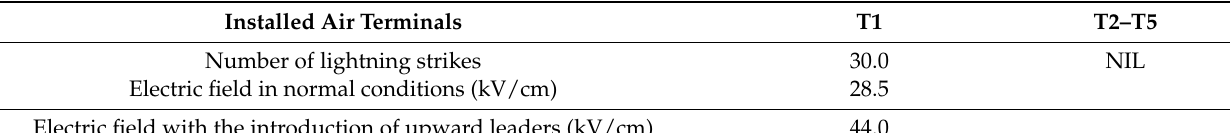
Table 9. Number of strikes and electric field on a pyramid-shape building.